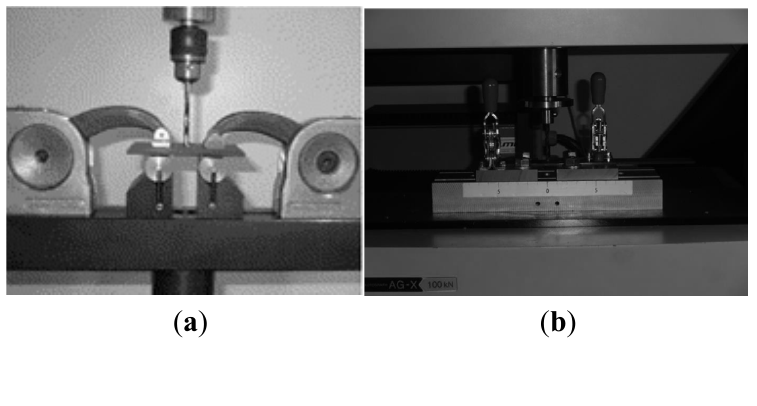
Figure 8. Delamination onset test: ( a ) device presented in [11]; ( b ) experimental